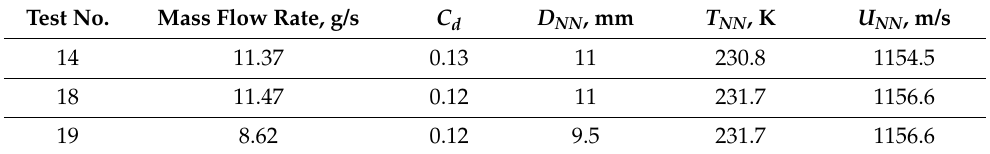
Table 2. Notional nozzle exit parameters used as hydrogen inlet boundary conditions in simulations *. Test